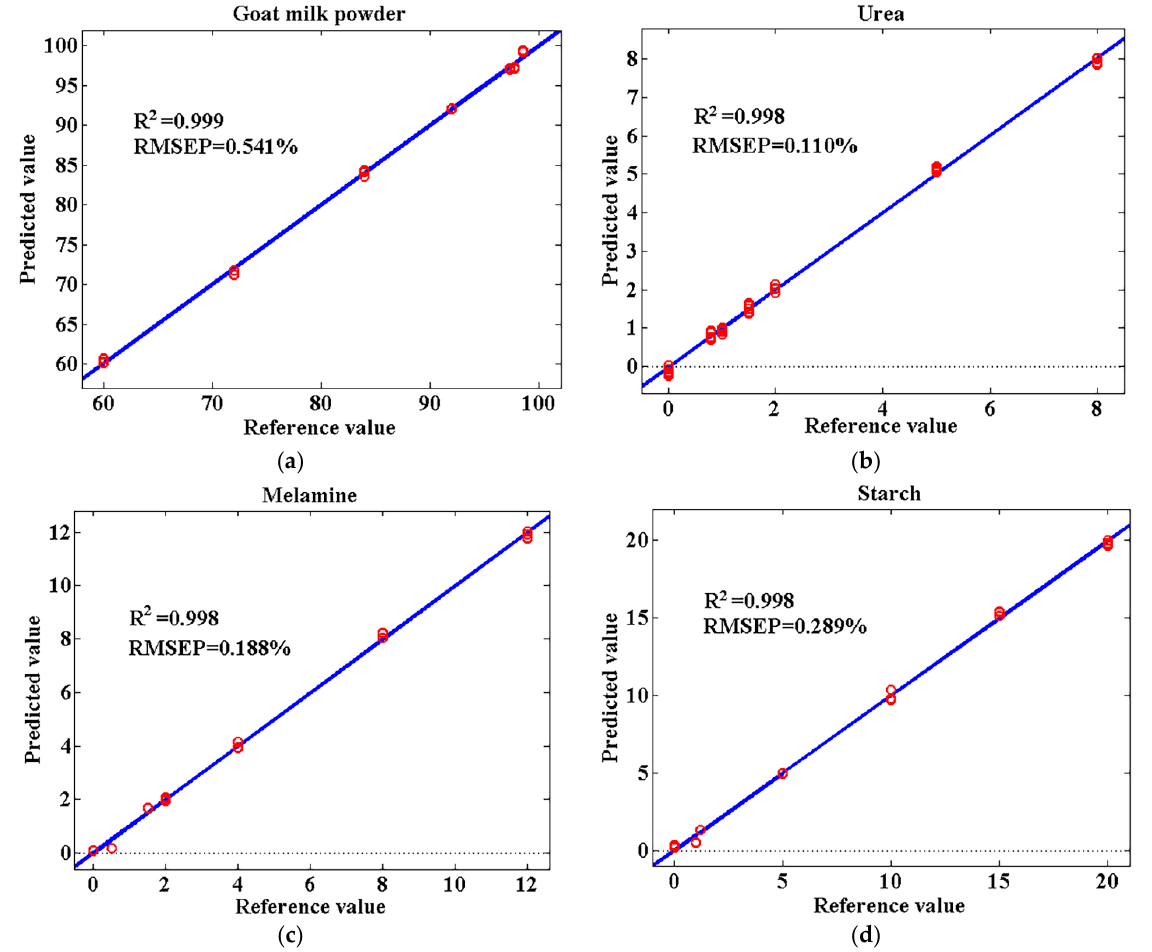
Figure 7. Predicted vs. reference plots for prediction set of the PLS2 model for goat milk powder determination ( a ), urea determination ( b ), melamine determination ( c ), and starch determination ( d ), based on the NON pretreated spectra.